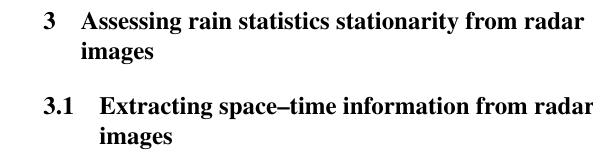
Figure 1. Examples of rain fields over Vaud Alps, Switzerland. (a) Situation map. The area of interest is delineated by the blue square. The red star denotes the location of the rain gauge network used for validation (Sect. 4). (b) Examples of rainstorms with dif- ferent space–time behaviours. (c) One example of a rain field with a temporally changing behaviour. In (b) and (c) the red arrows dis- played in the last panels denote the advection of the rainstorm in